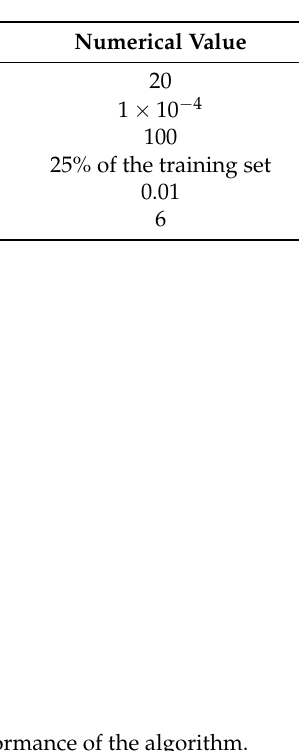
Table 3. Network model parameters.